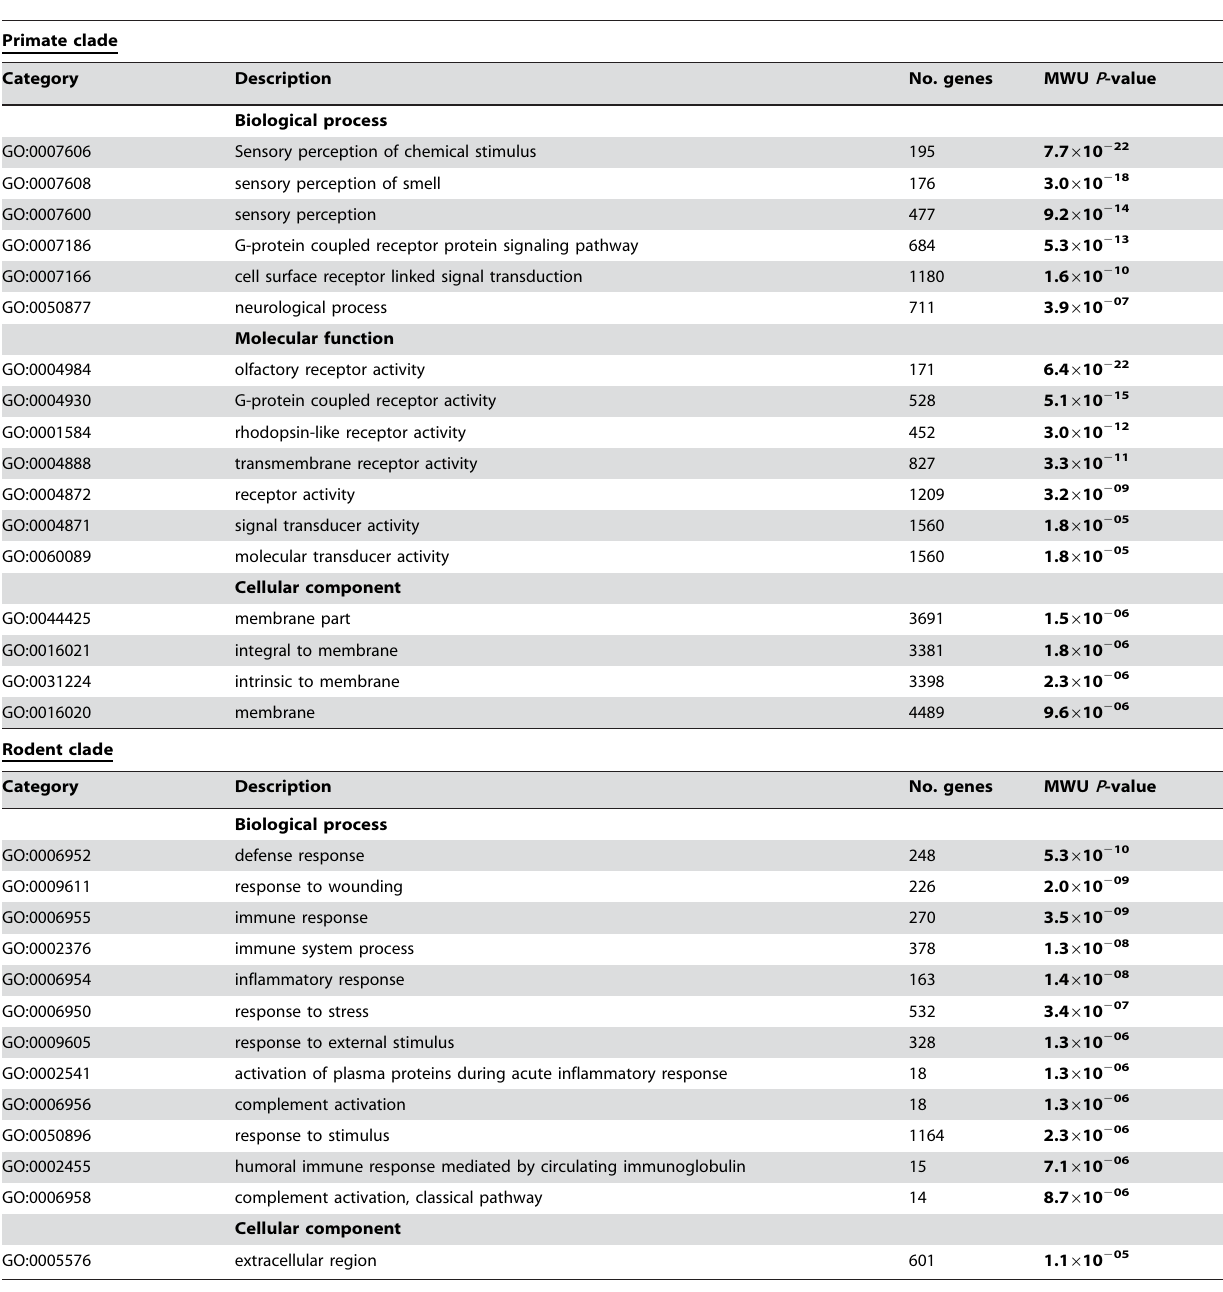
Table 4. GO categories showing an excess of small P -values under the primate- and rodent-clade tests.